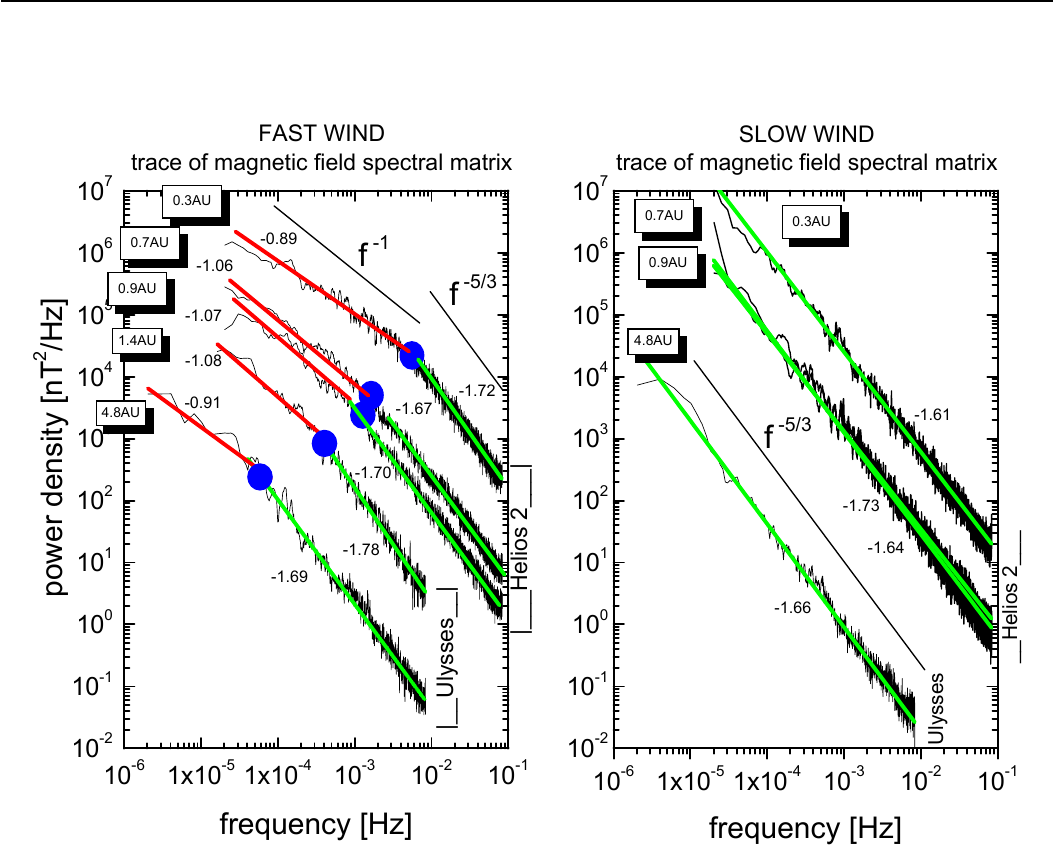
Figure 29: Left panel: power density spectra of magnetic field fluctuations observed by Helios 2 between 0.3 and 1 AU within the trailing edge of the same corotating stream shown in Figure 16, during the first mission to the Sun in 1976 and by Ulysses between 1.4 and 4.8 AU during the ecliptic phase. Ulysses observations at 4.8 AU refer to the end of 1991 while observations taken at 1.4 AU refer to the end of August of 2007. While the spectral index of slow wind does not show any radial dependence, the spectral break, clearly present in fast wind and marked by a blue dot, moves to lower and lower frequency as the heliocentric distance increases. Image adapted from Bruno et al.